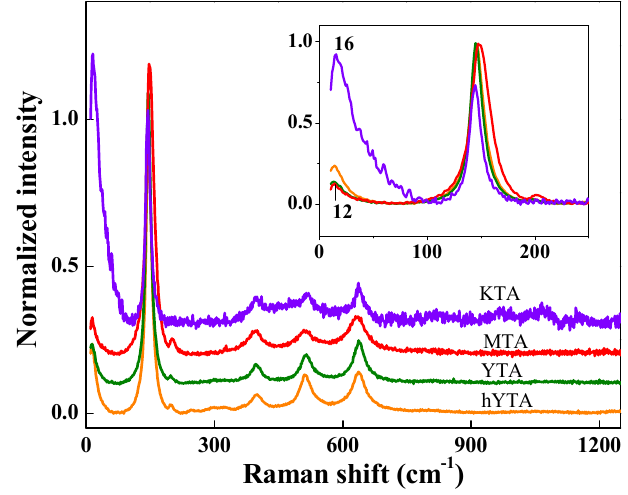
Figure 5. Raman spectra of the (K/M/Y/hY)TA catalysts (laser line of 514 nm). The non-framework anatase modes (E g located at 144, 197 and 640 cm − 1 , B 1g at